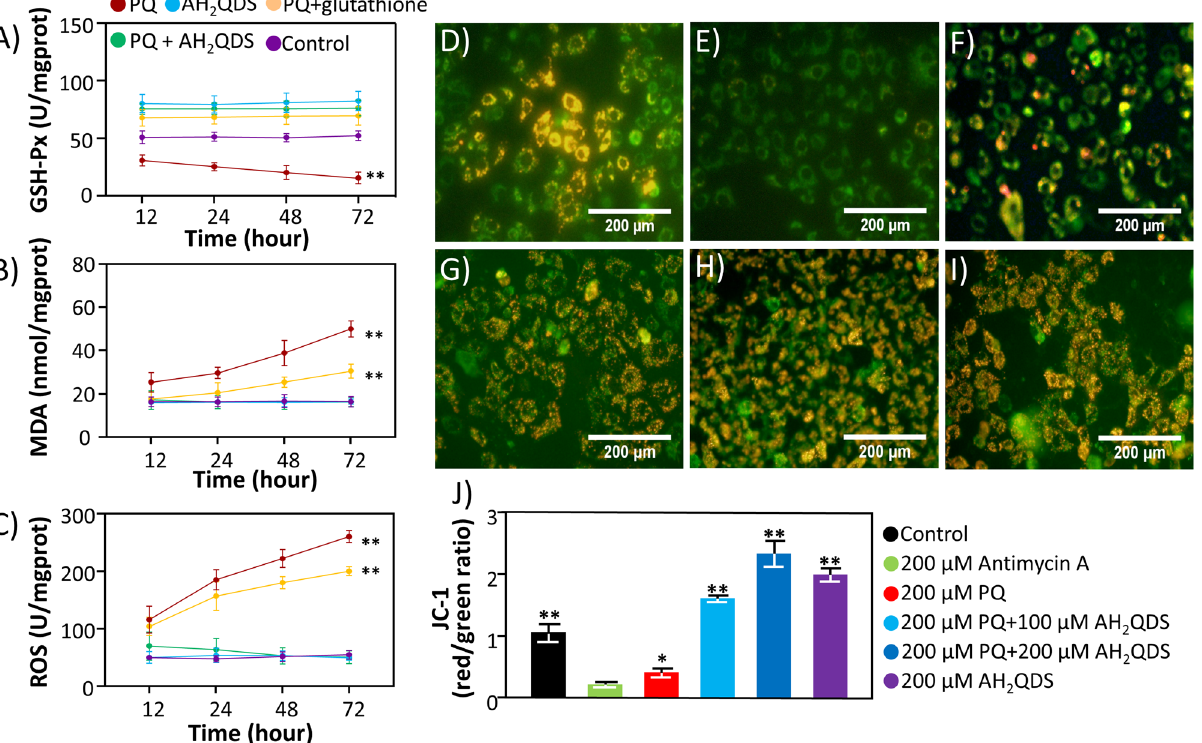
Figure 3. AH 2 QDS can protect the function of mitochondria and improve antioxidation in the treatment of PQ poisoning in vitro. ( A – C ) The levels of GSH-Px, MDA, and ROS were detected in different treatment groups. ( D – I ) The mitochondrial membrane potential of A549 cells in different treatment groups was detected. When the mitochondrial membrane potential is high, it can produce red fluorescence, whereas, when the level of mitochondrial membrane potential is low, it can show green fluorescence. ( D ) The control group without any handling. ( E ) For the 200 μM Antimycin A group, A549 cells were incubated with 200 μMAntimycin A. ( F ) is the 200 μM PQ group, A549 cells were incubated with 200 μM PQ. ( G ) shows 200 μM PQ + 100 μM AH 2 QDS group, A549 cells were incubated with 200 μM PQ and 100 μM AH 2 QDS. ( H ) represents 200 μM PQ + 200 μM AH 2 QDS group, A549 cells were incubated with 200 μM PQ and 200 μM AH 2 QDS. ( I ) means that in the 200 μM AH 2 QDS group, A549 cells were incubated with only 200 μM AH 2 QDS. ( J ) Mitochondrial membrane potential was determined using Mitochondrial Membrane Potential Assay Kit with JC-1. Mitochondrial JC-1 monomers (green) and aggregates (red) were observed under a fluorescence microscope. The mitochondrial membrane potential was presented as the ratio of J-aggregates to monomers. Data are presented as means ± SEM, n = 3, *P < 0.05, **P <